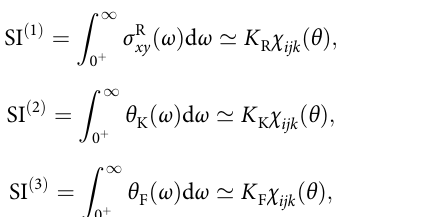
Fig. 5a that the spectral integral SI ð 1 Þ changes drastically with the magnetic order and the underlying spin topology. While this spectral integral follows the fi nite scalar spin chirality in the non- ð θ Þ / cos θ sin 2 θ , coplanar antiferromagnetic state, i.e., SI ð 1 Þ / χ ijk its value relates instead to the magnetocrystalline anisotropy in the collinear ferromagnetic state. Speci fi cally, the anisotropy function þ K sin 2 ð ϕ Þ þ K sin 4 ð ϕ Þ 47 with ϕ ¼ θ (cid:3) 54 : 7 (cid:1) K 0 1 2